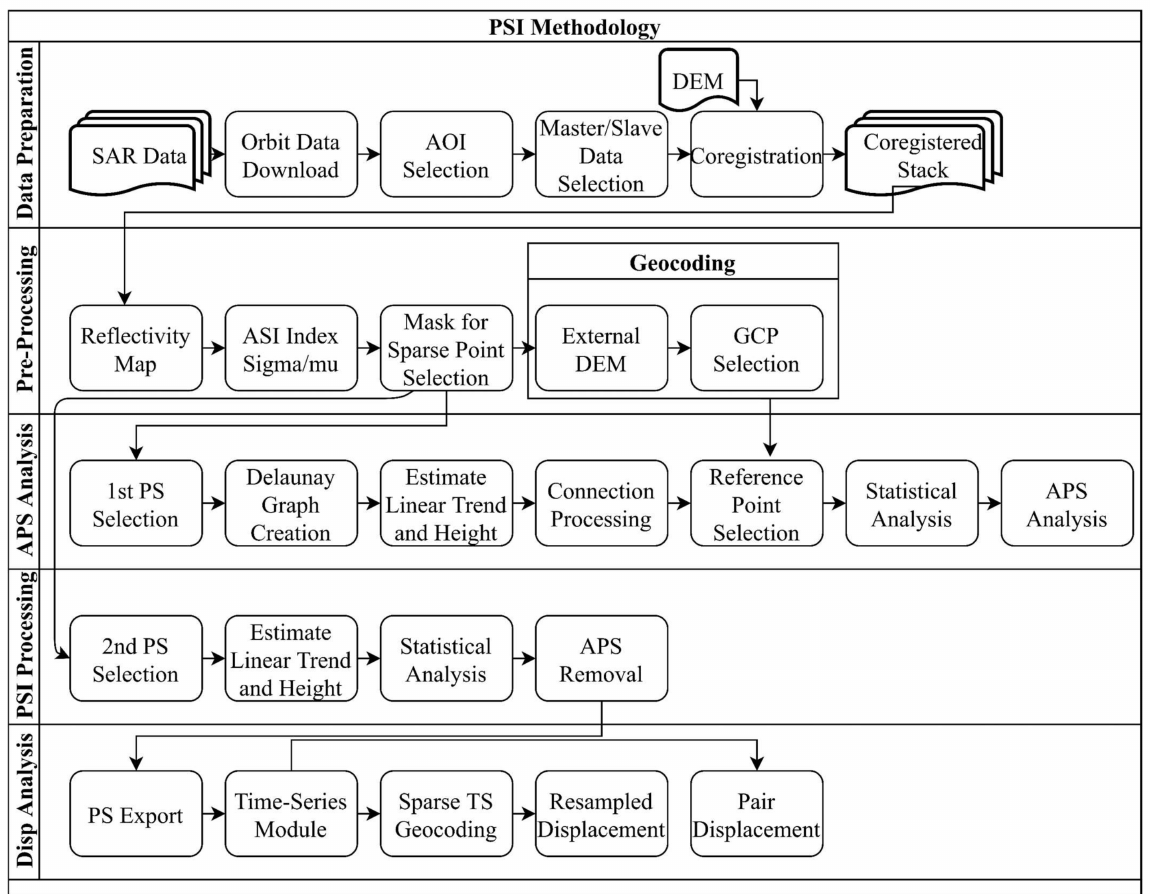
Figure 2. The flowchart of PSInSAR